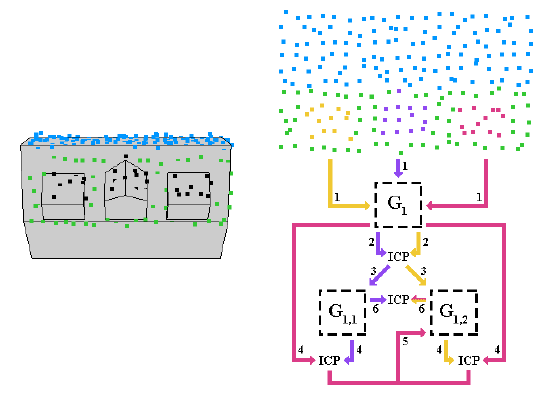
Figure 8. Example workflow of the fine registration